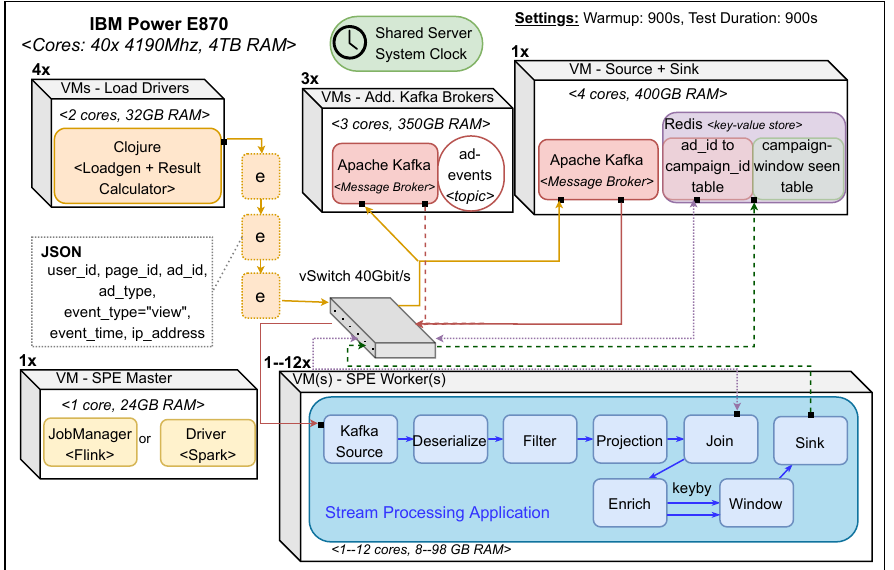
Figure 3. Benchmark and